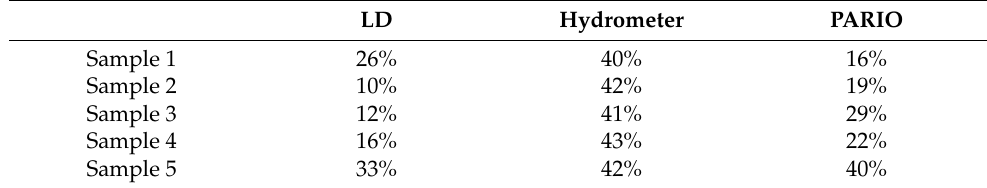
Table A1. Representation of the particles smaller than 2 µ m obtained by three tested methods.